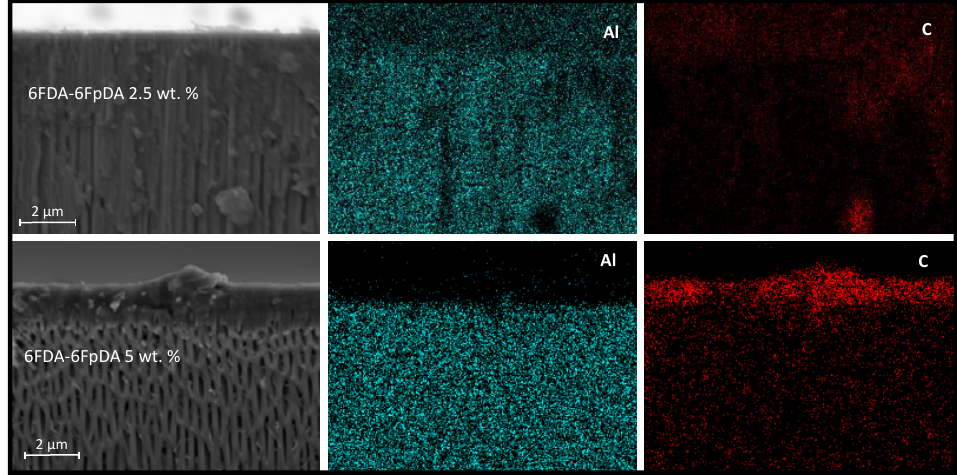
Figure 10. Cross-section micrograph and EDX analysis of 6FDA-6FpDA 2.5 wt. % ( upper part) and 6FDA-6FpDA 5 wt. % ( lower part).